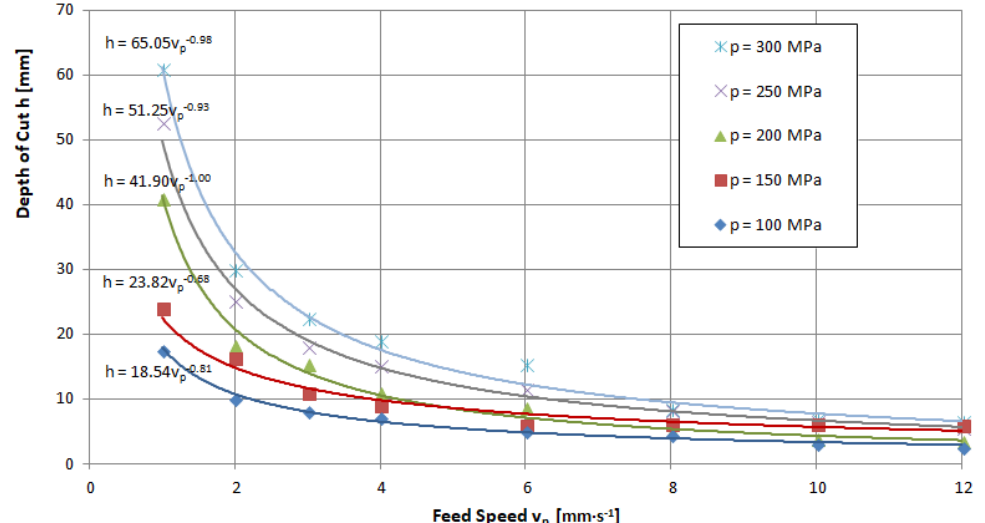
Figure 13. Influence of traverse speed and pressure on the depth of the cut of marble: nozzle internal diameter d w = 0.25 mm, flow of abrasive 𝑚(cid:4662) (cid:3028) = 6.7 g·s − 1 .